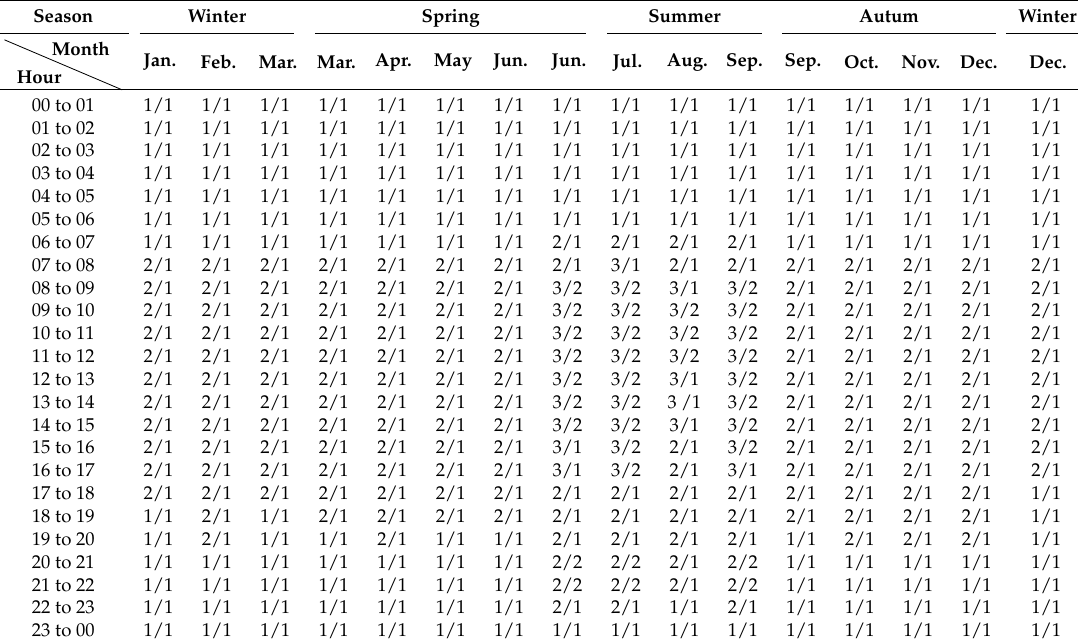
Table 4. Number of connected transformers that minimize losses on Sec SS 3 (WD/non-WD). Season